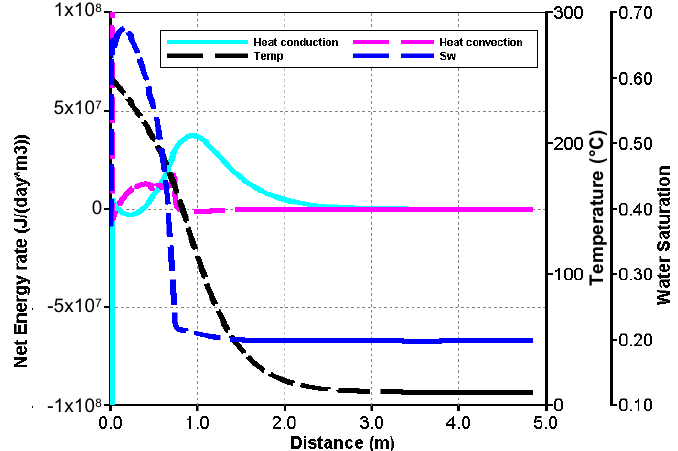
Figure 11. Conductive and convective heat transfer rates versus distance compared with temperature and water saturation profiles for the HE model.